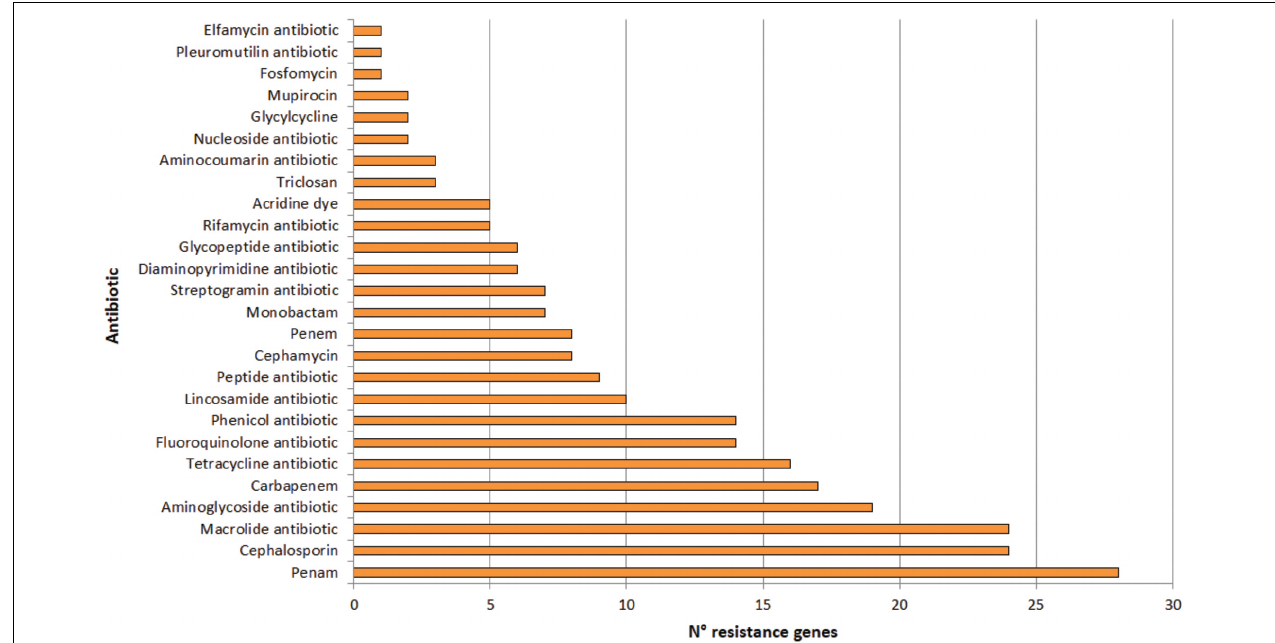
FIGURE 7 | Number of genes conferring resistance to different types of antibiotics in the Puquio de Campo Naranja plasmidome. Putative antibiotic resistance genes were identified by the RGI software using the CARD database.